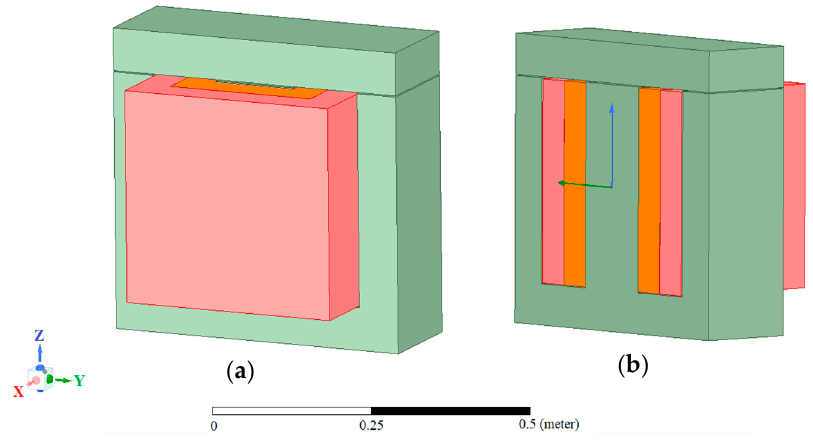
Figure 2. The conventional transformer model half symmetric front view ( a ) and it across section view ( b ).